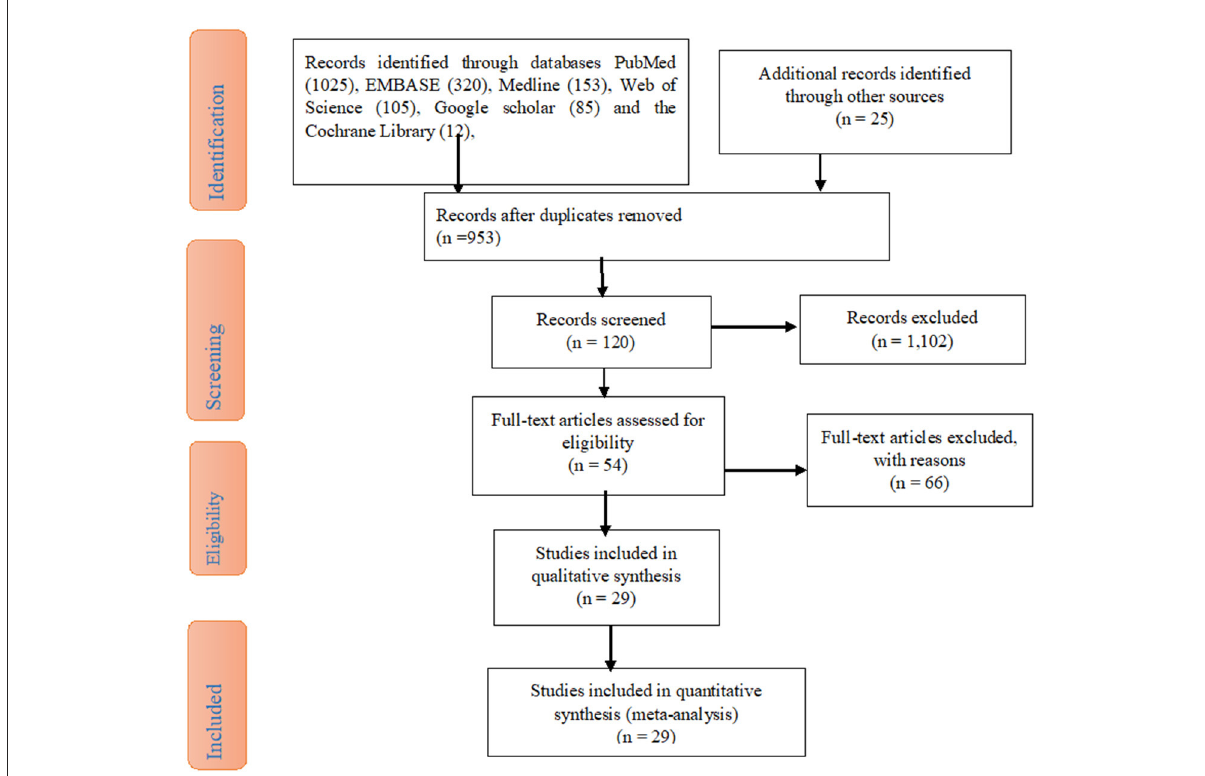
FIGURE1 A PRISMA diagram of the study selection procedure on the acceptance of the COVID-19 vaccine in sub-Saharan Africa Countries.